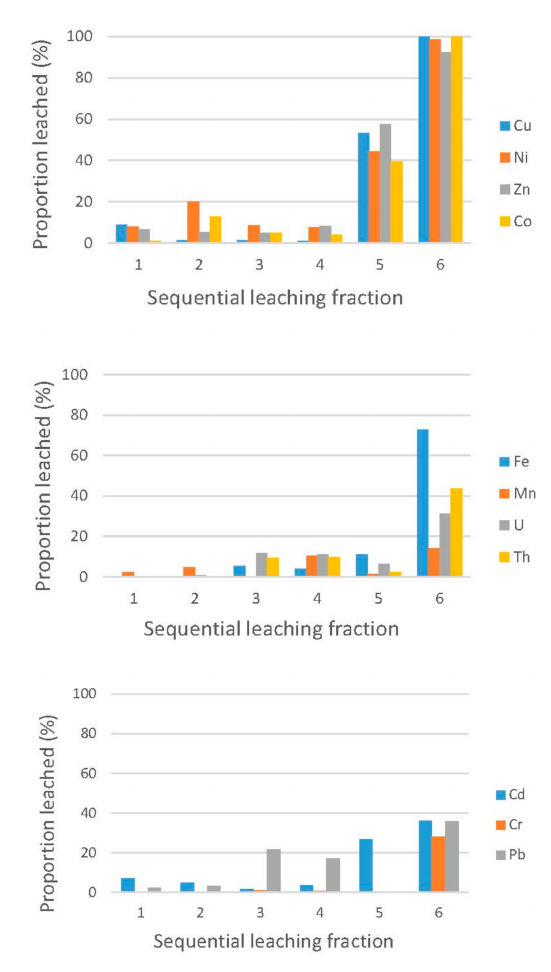
Figure 3. Release of metals from unprocessed Talvivaara ore in laboratory sequential leach